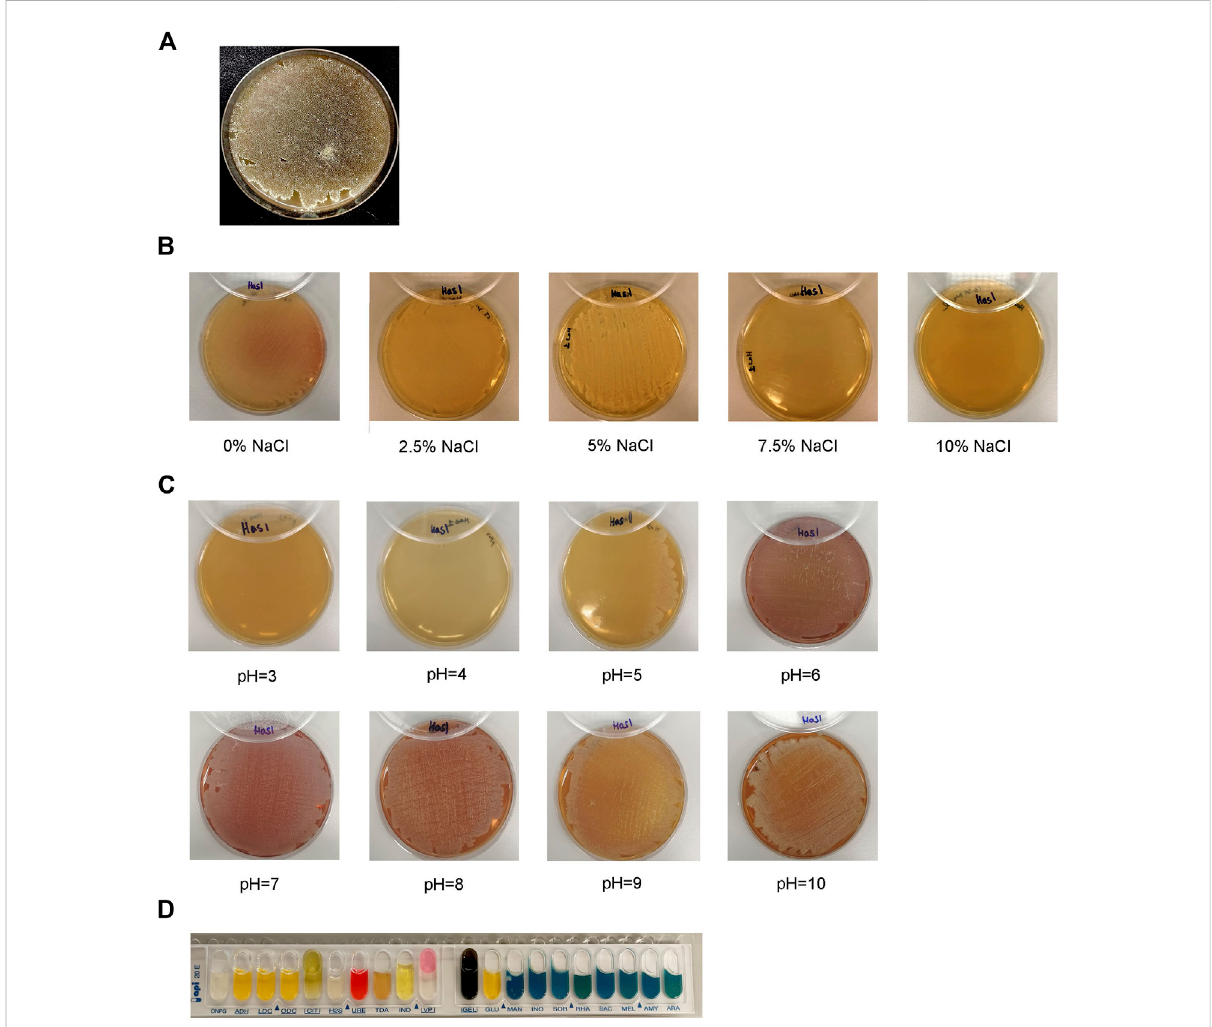
FIGURE 2 Morphological, physiological, and biochemical characterization of the bacterial isolate HAS1. (A) . Growth, shape, color of the mycelium of the isolate HAS1 and spore formation on ISP3 agar 10 days after bacterial inoculation with an incubation at 28 ° C. (B) . Physiological characterization of HAS1 isolate using bacterial growth on the 5,339 agar with different NaCl concentrations (0, 2.5, 5, 7.5 and 10%) after incubation for 10 days at 28 ° C. (C) .GrowthofHAS1onISP2agarwithdifferent p H(3,4,5,6,7,8,9,and10)aftera10daysat28 ° C. (D) .BiochemicaltestingofHAS1usingtheAPI 20E